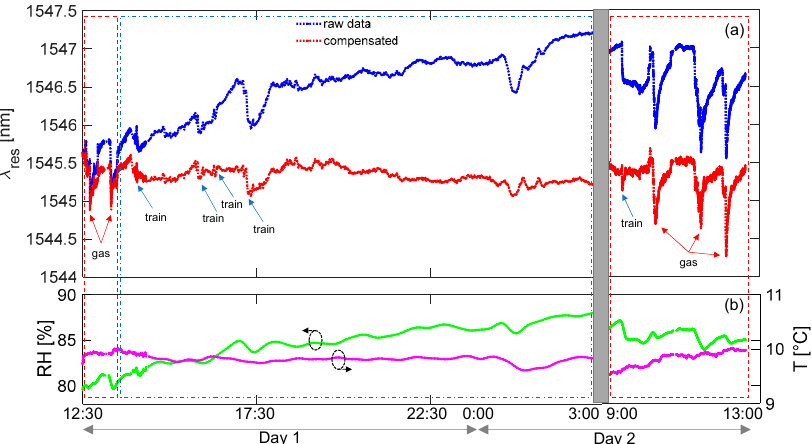
Figure 20. Testing of the liquified monitoring gas detection system: ( a ) response of the sensor in terms of resonance wavelength (raw and compensated data); ( b ) temperature (magenta) and humidity (green) measurements used for the compensation. Red boxes indicate the testing sessions whereas blue boxe is for the line under normal operation (Adapted from [147]).